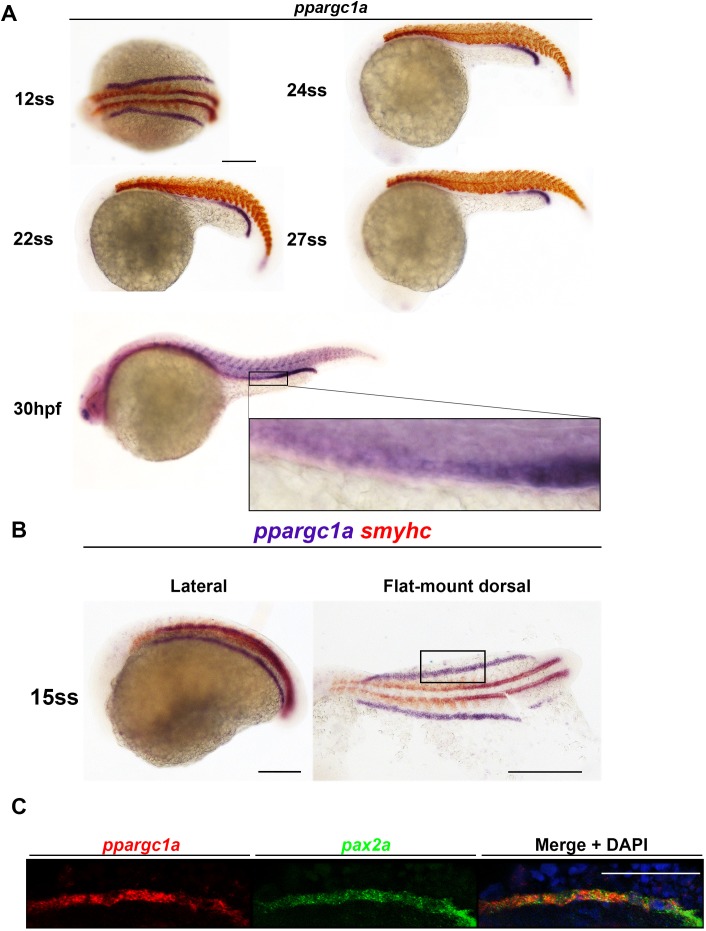
ppargc1a mRNA transcripts are expressed throughout the intermediate mesoderm before restricting to the distal nephron segments.(A) Additional time points of ppargc1a (purple) mRNA expression illustrating the restricting domain from the 20 ss to the 28 ss. deltaC (12 ss) and smyhc (22–27 ss) were used to stain somites (red). ppargc1a mRNA expression at 30 hpf with a 20 X inset to show light proximal expression detectable at this stage. Scale bar = 90 μm. (B) Lateral (left) and flat-mounted dorsal (right) images of double WISH in 15 ss WT embryos for ppargc1a (purple) in and smyhc (red). The box indicates the approximate region of panel C. Scale bars = 110 μm (lateral) and 200 μm (dorsal flat-mount). (C) Double FISH in 15 ss WT embryos showing colocalization of ppargc1a (red, left) with pax2a (green, middle) and the images merged (right) with DAPI (blue). Scale bars = 100 μm.